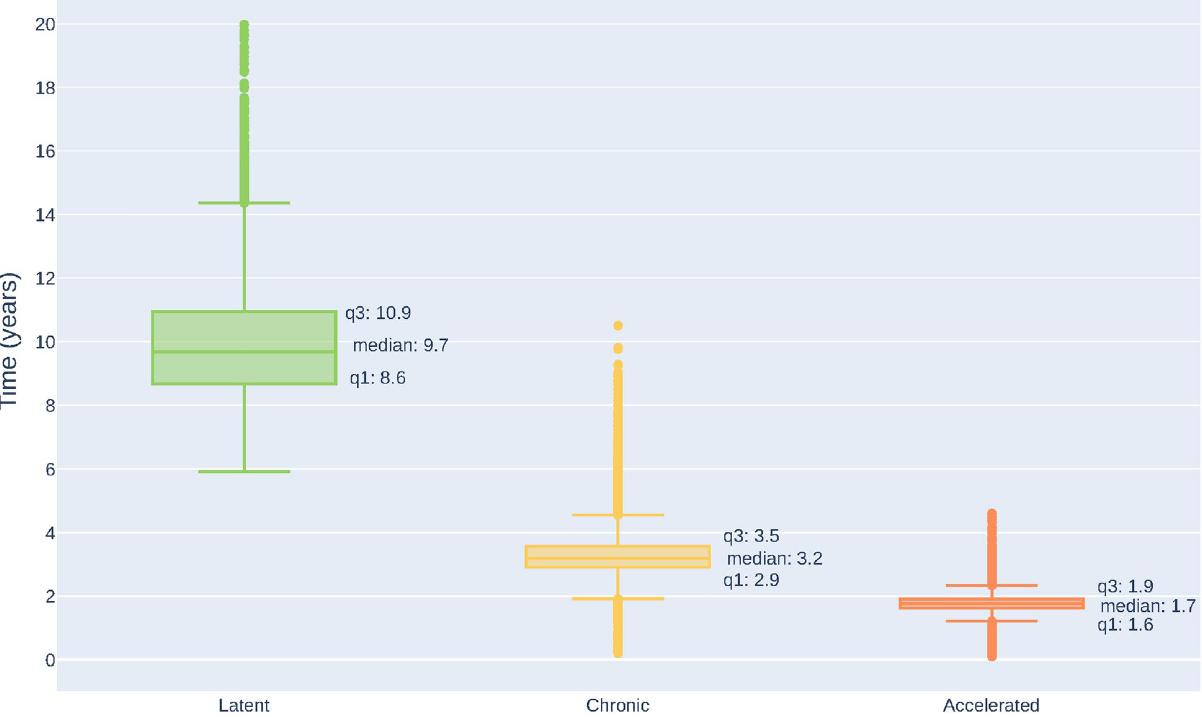
Figure 4. Duration of different phases of CML progression. For each parameter combination of the model, we simulated 100 instances. We selected the parameter combinations having a median duration over the 100 cases within the previously reported ranges. For these parameter combinations, we plot the distribution of the durations. All the distributions have a long tail towards long durations due to the stochastic nature of the